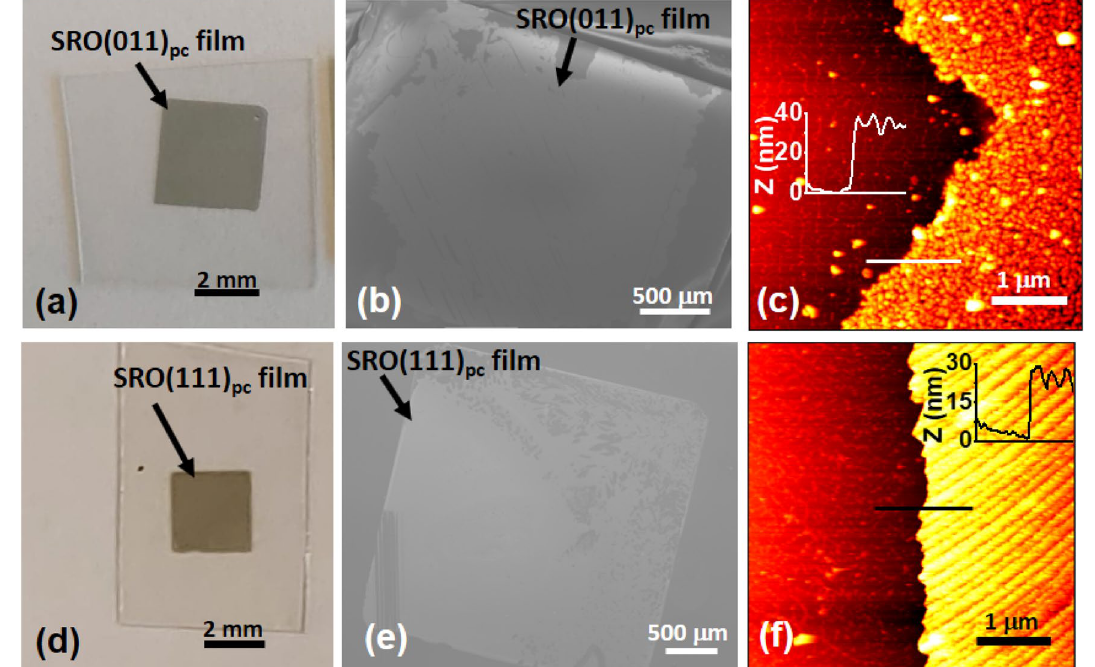
Figure 3. SRO(011) pc and SRO(111) pc films after the epitaxial lift-off and the transfer to Si(001) substrates. Millimeter-sized SRO(011) pc ( a ) and SRO(111) pc ( d ) films on the supporting polyethylene terephthalate (PET) substrates. SEM images of SRO(011) pc ( b ) and SRO(111) pc ( e ) on Si(001) substrates. Panel ( c ) and ( f ) show AFM data at the edges of SRO(011) pc /Si(001) and SRO(111) pc /Si(001), respectively. The insets show the thickness of transferred SRO